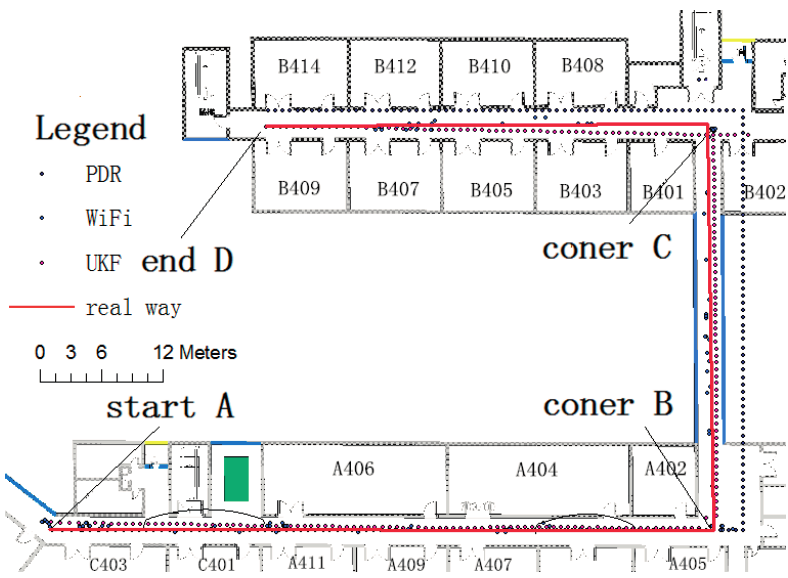
Figure 14. UKF positioning comparison test.